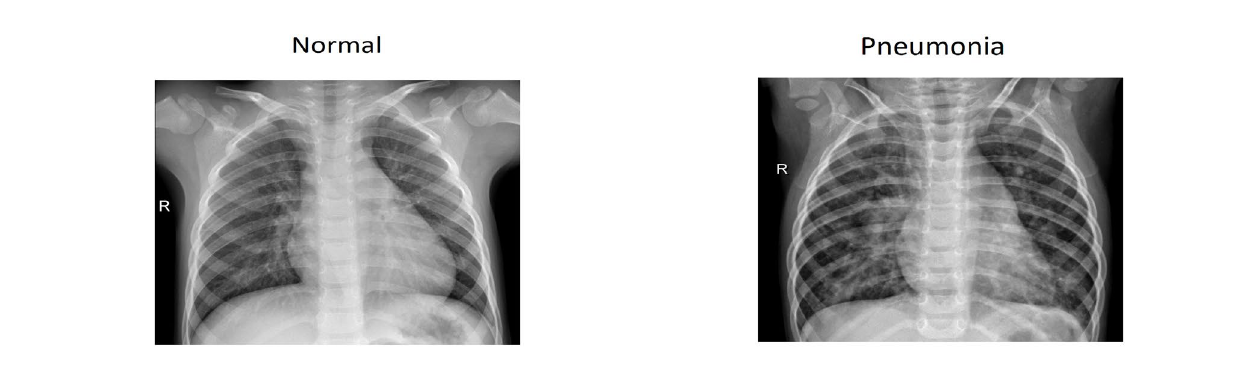
Figure 1. Visualizations of X-ray images of Normal and Pneumonia chest.